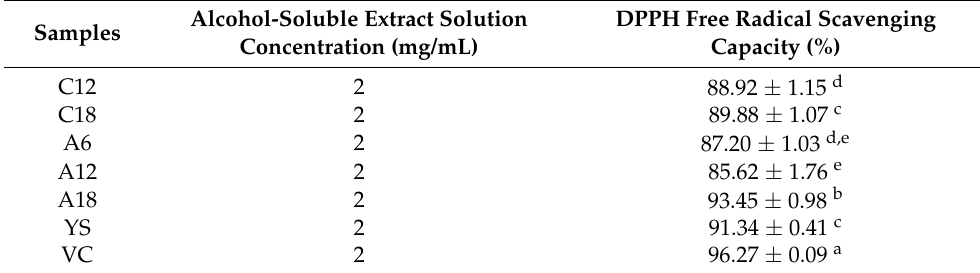
Table 2. DPPH free radical scavenging capacity of five batches and